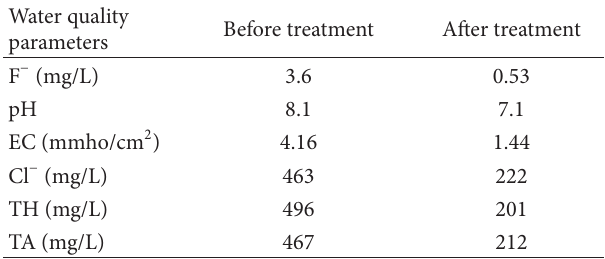
T 5: Field trial results of